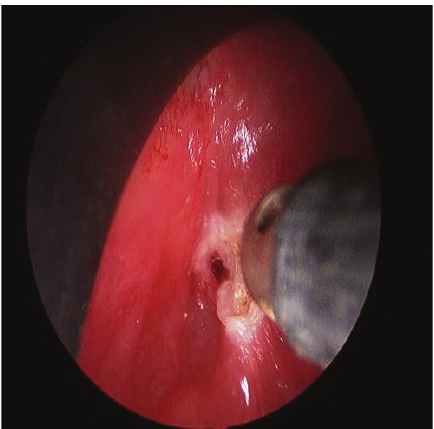
Figure 7: Cauterization of the orifice.